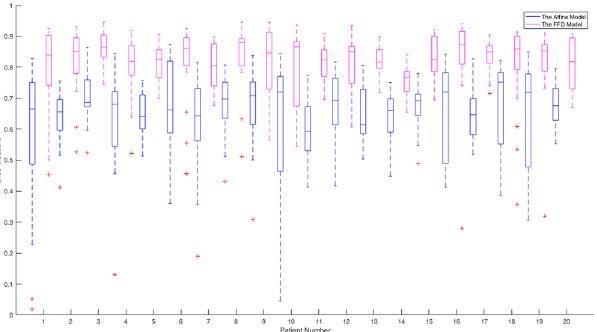
Figure 4. The boxplot of Dice results using the affine and FFD model on the Sliver07